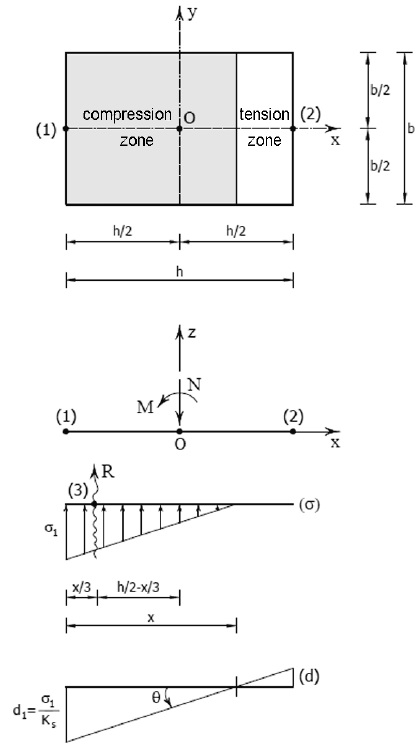
Fig. 1. Soil pressure distribution and displacement profile of soil